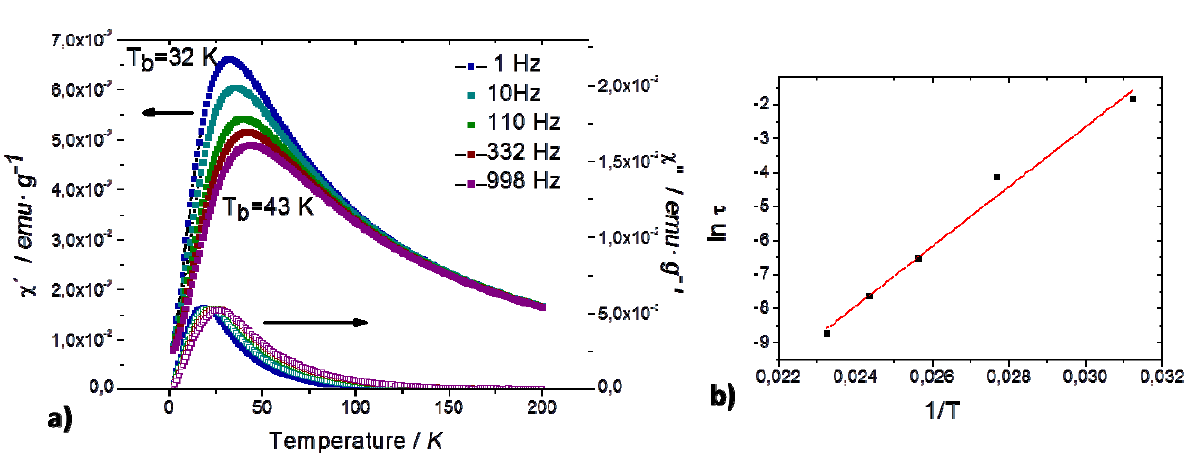
Figure 1. ( a ) Frequency dependence of AC susceptibility of the NPs vs. Temperature with amplitude of 17 Oe; ( b ) Arrhenius law fit for the nanoparticles.